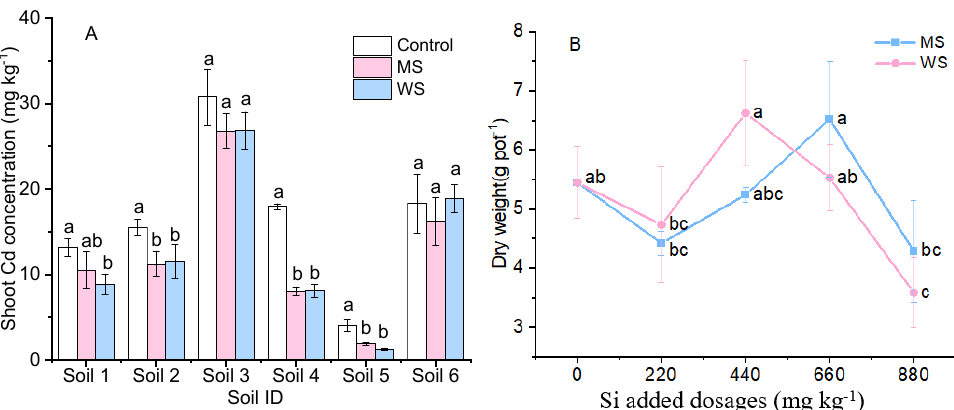
Figure 2. Cd concentration of amaranth shoot in six Cd-contaminated soils under 440 mg·kg − 1 Si treatments ( A ) and in soil 3 under 0, 220, 440, 660, and 880 mg·kg − 1 added Si dosages ( B ). Control, non-amendment treatment; MS, 4A molecular sieve; WS, wollastonite. Data are means ± SE ( n = 4). Different letters above the adjacent bars or lines denote a significant ( p < 0.05) difference among the treatments in the same soil.